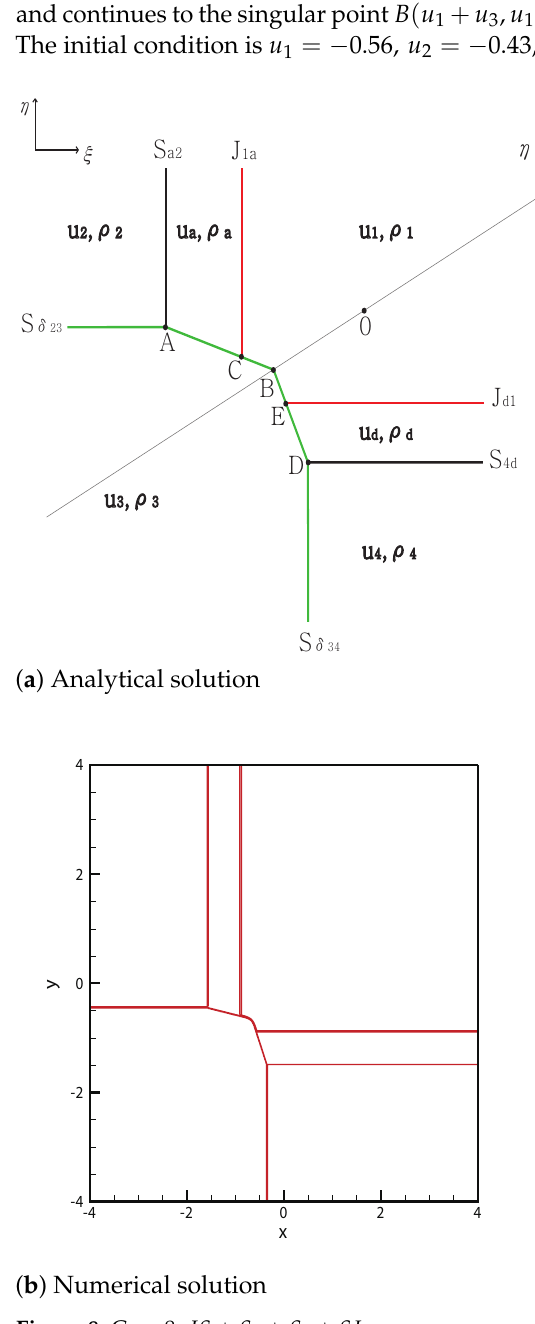
Figure 8. Case 8. JS + S δ + S δ + SJ